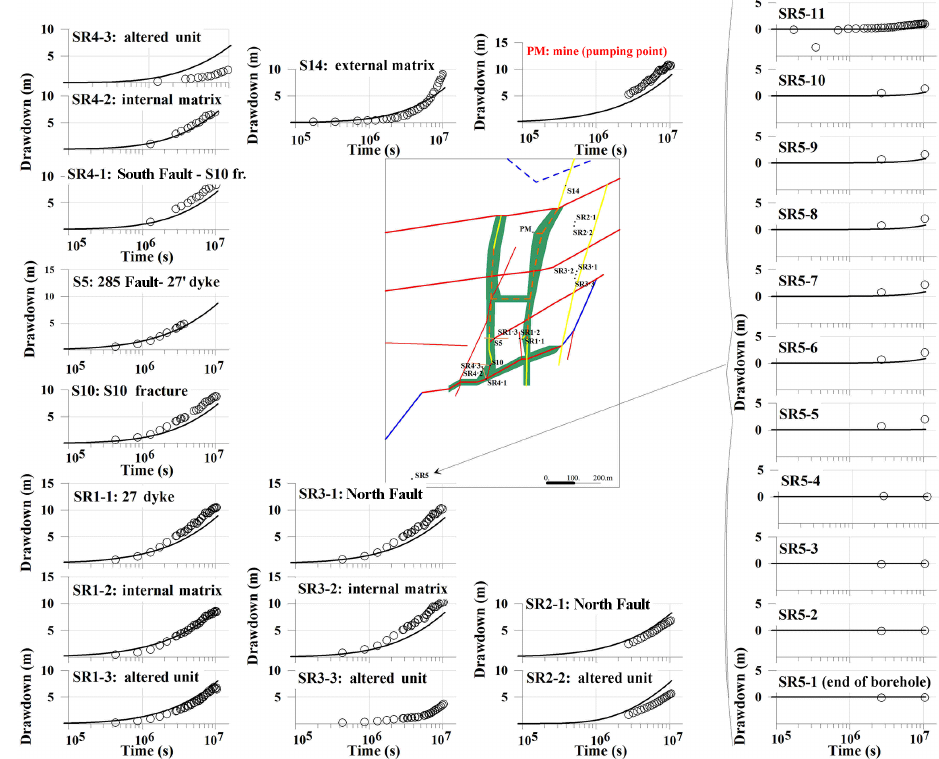
Figure 11. Blind prediction of the long-term pumping of the mine (point PM), using calibrated with the SR4-1 cross-hole test. This pumping lasted for 4 months, and its effects reached all observation points. Measurements are represented by circles, and model results are represented by continuous